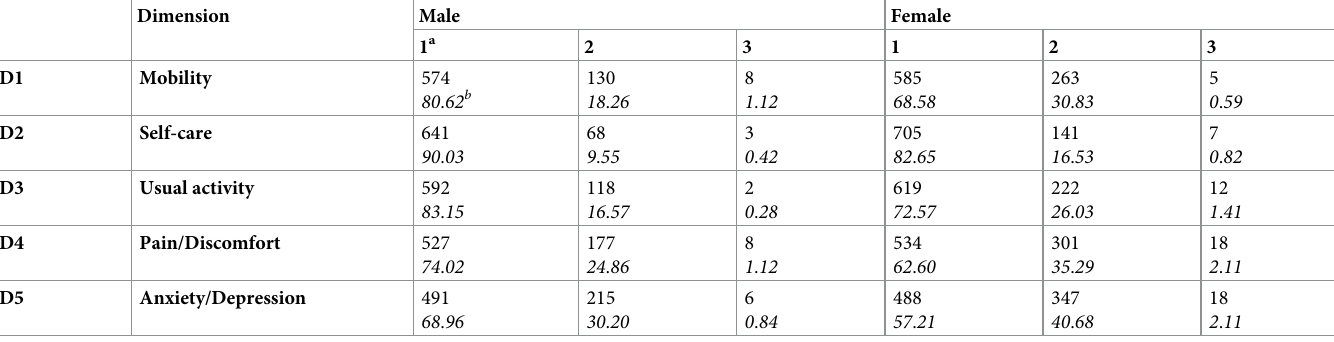
Table 4. Profiles of EQ–5D by gender, number of respondents. Dimension